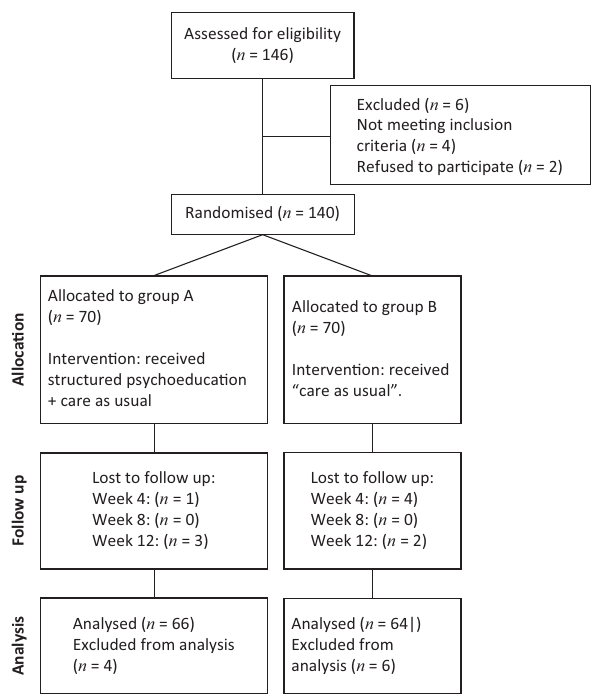
TABLE 1-A2: The structured psychoeducation intervention using a modified version of Sharif et al. 28 Session